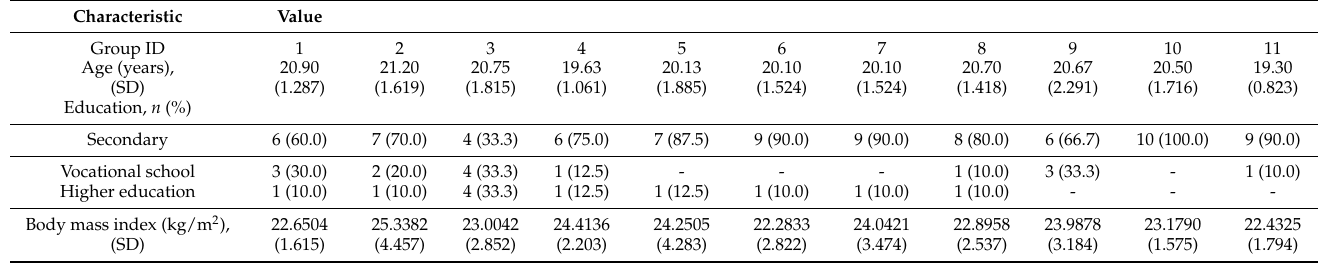
Table 1. Demographic and anthropometric data for the groups at the beginning of their conscrip- tion